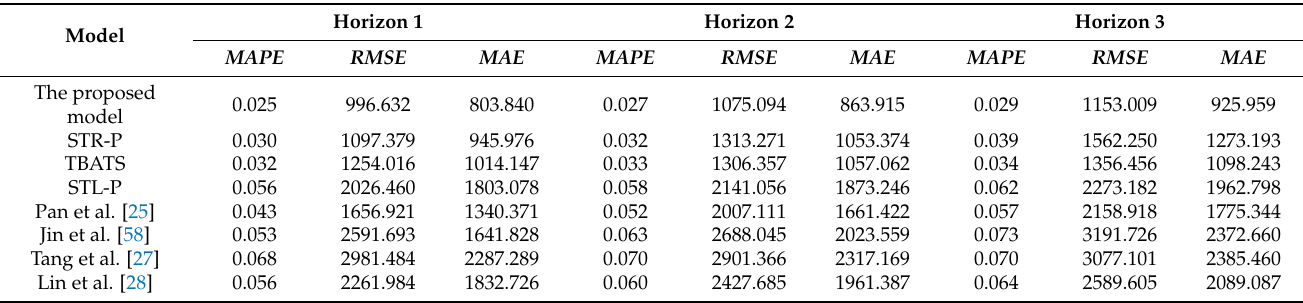
Table 8. Prediction performance of different models in